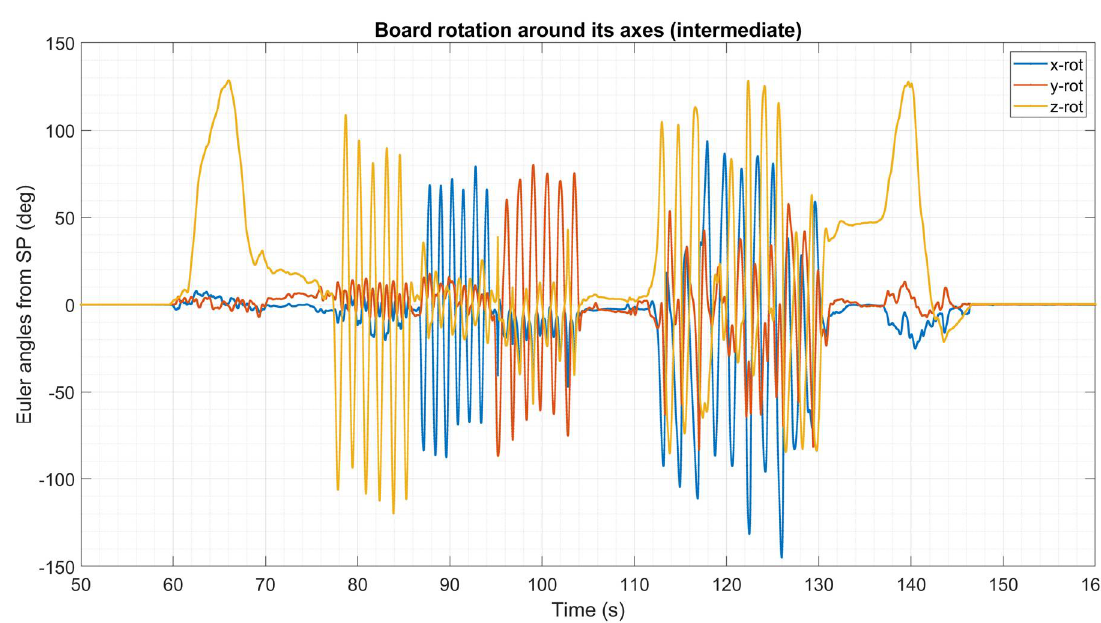
Figure 2. Exemplificative description of the movements of the board in terms of Euler angles for the intermediate trial. As evident, from the graph, the first three rotations were performed around one axis at a time, while the last part of the movement is a combination of the movement around the three axes.